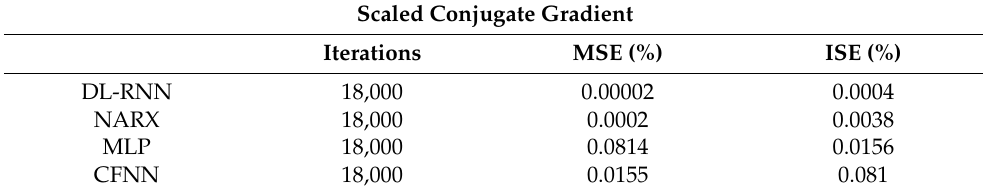
Table 5. Results of testing (SCG algorithm, FD001